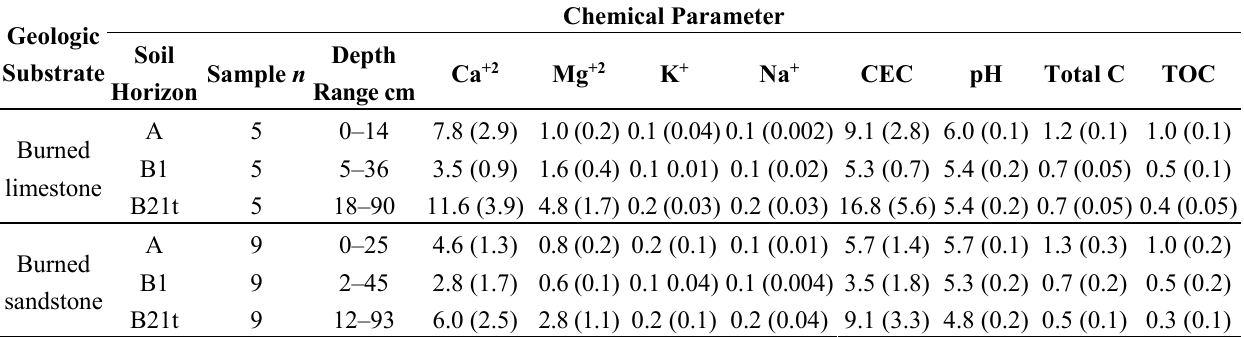
Table 10. Physical and chemical characterization of burned limestone ( n = 5 sites) and sandstone ( n = 9 sites) soils on the Dude Wildfire study area 10 years postfire. Depths are ranges in centimeters for the sample size n , with soil chemistry parameter means by horizon. Values for Ca +2 , Mg +2 , K + , Na + , and total cation exchange capacity (CEC) are in cmol·kg − 1 with standard error of the mean (se); and values are in percent for Total Carbon and Total Organic Carbon with standard error of the mean (se). pH is